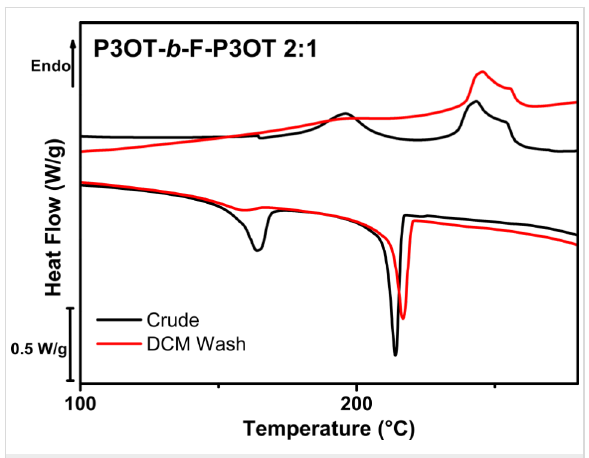
Figure 1: Differential scanning calorimetry thermogram (second cycle, 10 K/min) of P3OT- b -F-P3OT 2:1 before (black) and after (red) washing with dichloromethane. The reduction in the thermal transi- tions occurring below 200 °C, attributed to P3OT, indicate that a sub- stantial amount of P3OT homopolymer was present in the crude polymer, but was removed by extraction.